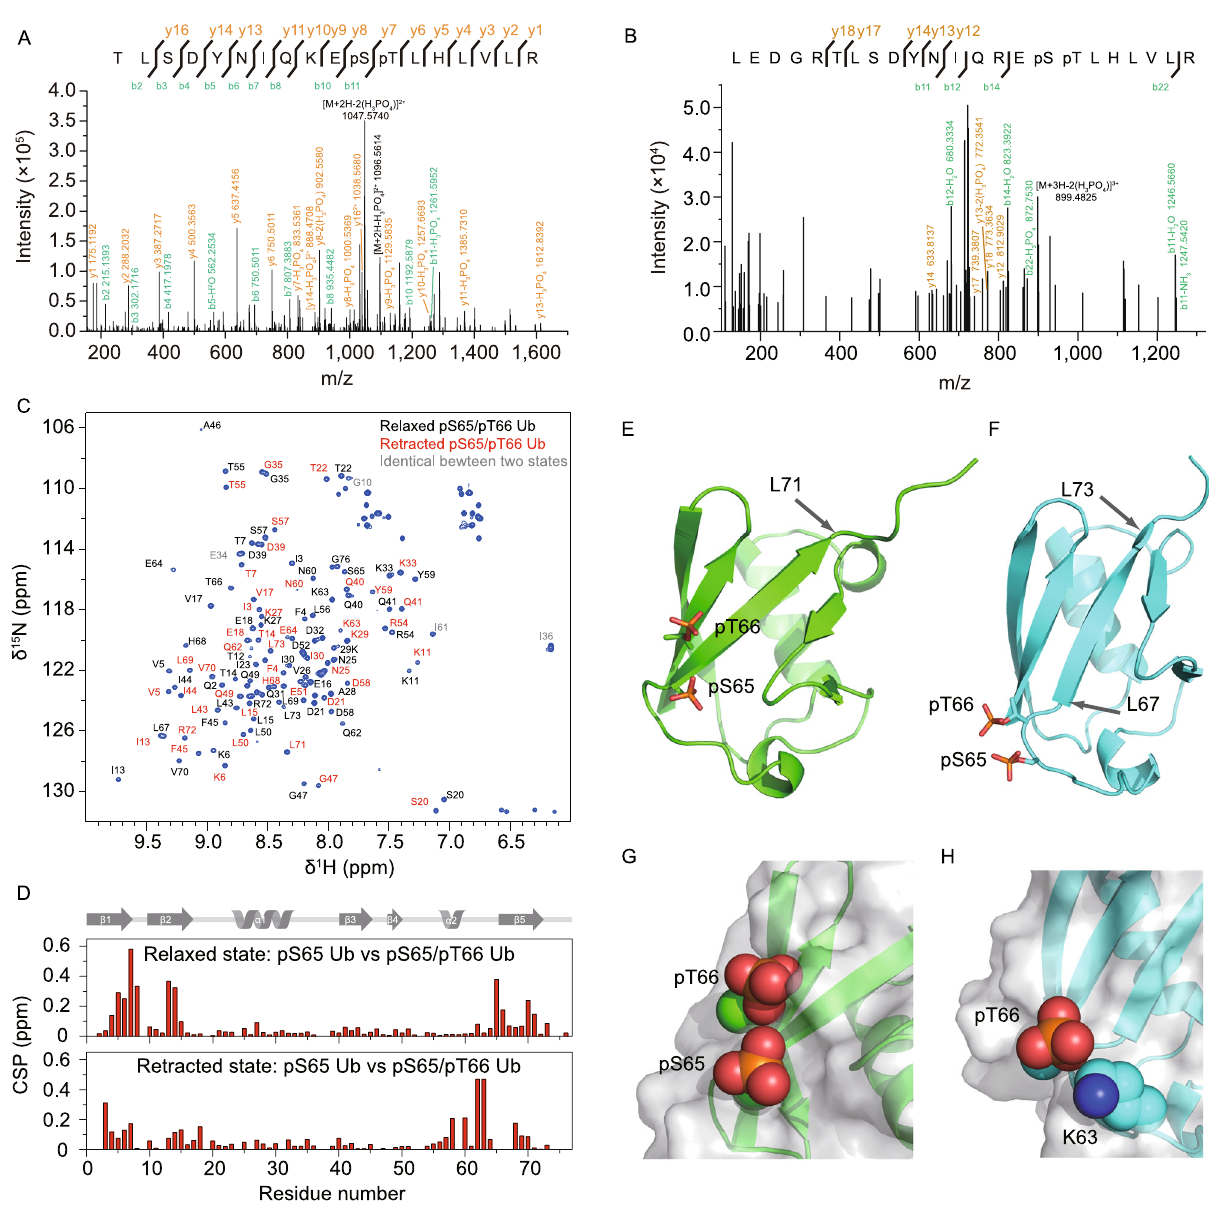
Figure 1. Double phosphorylation of Ub by PINK1 at S65 and T66 sites . (A) MS2 spectrum showing the peptide derived from Ub containing the two phosphorylated residues, with the Ub protein phosphorylated in vitro . (B) MS2 spectrum showing the double phosphorylated Ub peptide, with the Ub protein phosphorylated by PINK1 in cells. To avoid the formation of polyubiquitin and to simply analysis, Ub 7KR mutant was co-transfected with soluble PINK1 (residues 102 – 521) into HEK293 cells. (C) NMR analysis of pS65/pT66 Ub. 2D 1 H- 15 N HSQC spectrum collected at 25 °C in pH 7.4 buffer on a 600 MHz spectrometer. The peaks can be assigned to a C-terminally relaxed state and retracted state undergoing slow exchange, with some peaks degenerate. (D) NMR chemical shift perturbations (CSPs) are relatively small, when comparing to pS65 single phosphorylated Ub in the same conformational state. The averaged CSP in ppm is calculated with the equation Δδ = [0.5 × Δδ H 2 + 0.1 × Δδ N 2 ] 1/2 , with Δδ H and Δδ N the CSPs in 1 H and 15 N dimensions, respectively. Ub secondary structure is indicated. (E and F) Solution structures of pS65/pT66 Ub in the C-terminally relaxed and retracted state, respectively. The retracted state mainly differs from the relaxed state in the register of the C-terminal β -strand ( β 5), moving up by 2 residues. (G) Close-up view of the phosphoryl groups in the relaxed state, which are partially buried. (H) Close-up view of residues pT66 and K63 in the retracted state. The proximity of pT66 and K63 suggests electrostatic interaction, which would explain the increased stability of Ub retracted